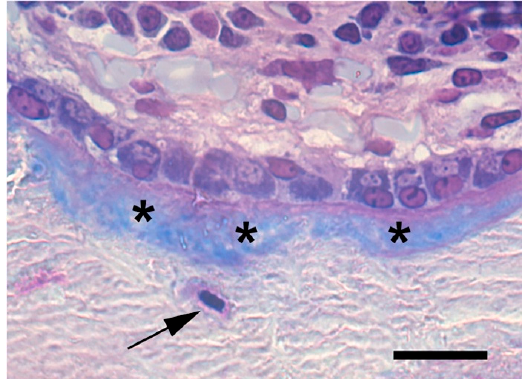
Figure 1. Osteoblasts rimming a bone trabecula with unmineralized (asterisk) and mineralized matrix with embedded osteocytes (arrow). Formalin-fixed, non-decalcified plastic-embedded tis- sue, May-Grünwald-Giemsa. Scale bar: 25